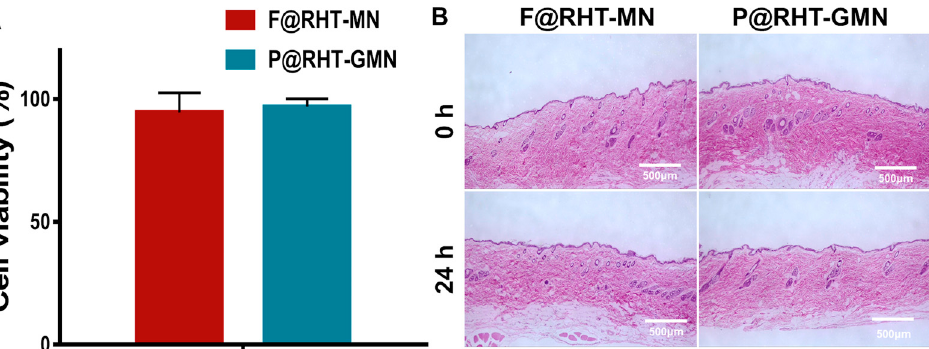
Figure 10. ( A ) The cytotoxicity of passive MNs and gas-propelled MNs after incubating HaCaT cells for 24 h ( n = 5). ( B ) The skin irritation of passive MNs and gas-propelled MNs.